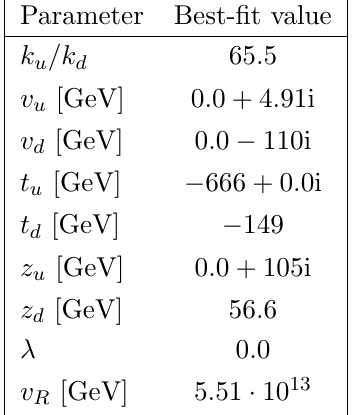
Table 4 . Parameter values of the extended model with normal neutrino mass ordering correspond- ing to the minimum value of the (cid:31) 2 function.